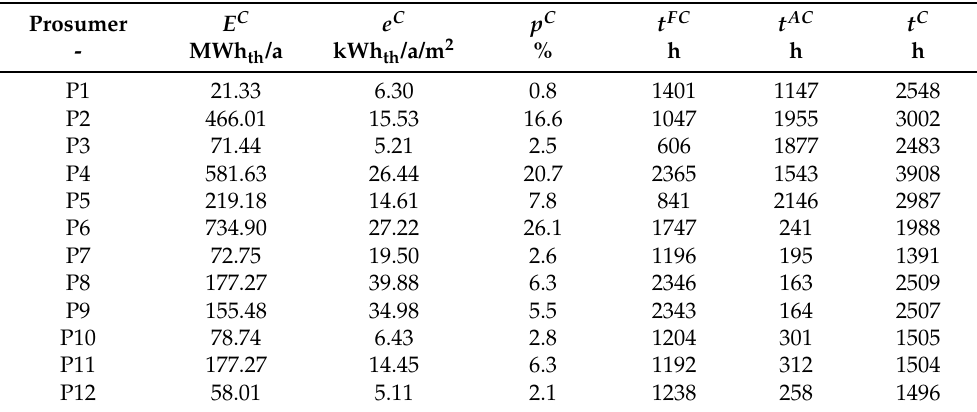
Table 3. Prosumer cooling demand, duration of cooling period and whether it is provided by AC or